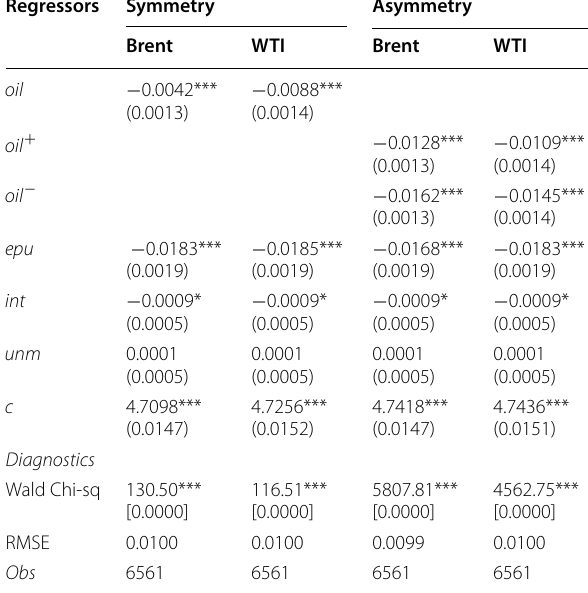
Values in brackets are standard errors, while those in parentheses are probabilities. *** and * indicate significance at 1% and 10% critical levels,